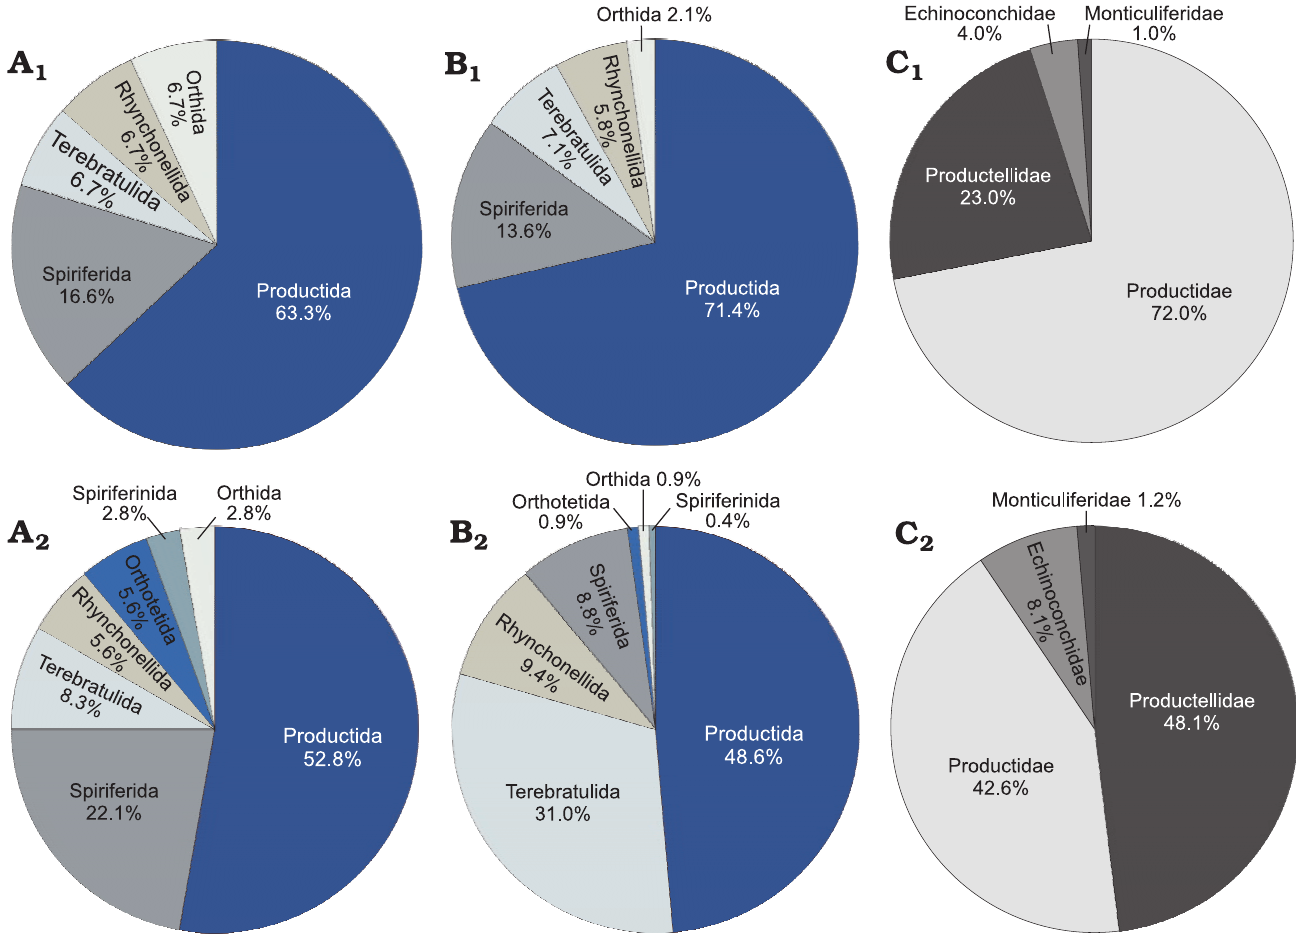
Fig. 6. Pie diagrams showing composition of the Brigantian (uppermost Visean) Ricklow Quarry mud mound complex brachiopod fauna. A . Species per- centage distribution of the various brachiopod orders for unit FA1 (A 1 ), FA2 (A 2 ). B . Specimen percentage distribution of the various brachiopod orders for unit FA1 (B 1 ), FA2 (B 2 ). C . Specimen percentage distribution of the various families of the order Productida for unit FA1 (C 1 ), FA2 (C 2